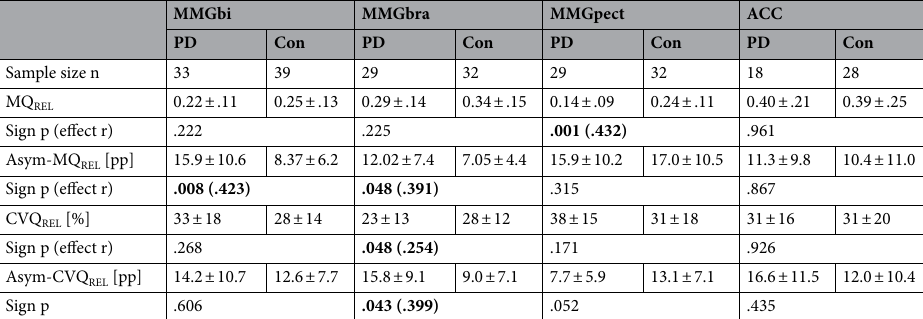
Table 3. Statistical values of parameters of Q REL for each signal. Displayed are the arithmetic mean and SD, significance p of t-test for independent variables and effect size r of MQ REL and CVQ REL and their side asymmetries (Asym-MQ REL ; Asym-CVQ REL comparing PD and Con regarding the signals MMGbi, MMGbra, MMGpect and ACC. Significant results are displayed in bold.